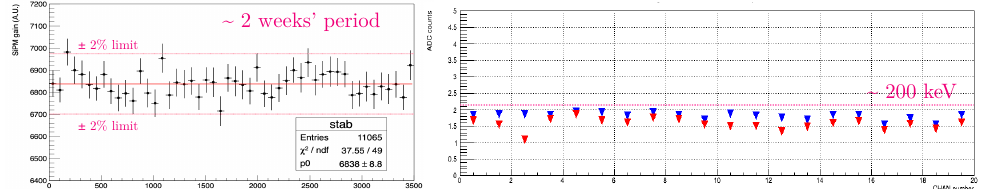
Figure 12. Relative SiPM gain stability over 2 weeks against MIP peak for the central channel ( left ). Charge pedestals expressed in ADC counts RMS for all Module-0 channels for two subsequent runs (blue and red colours).